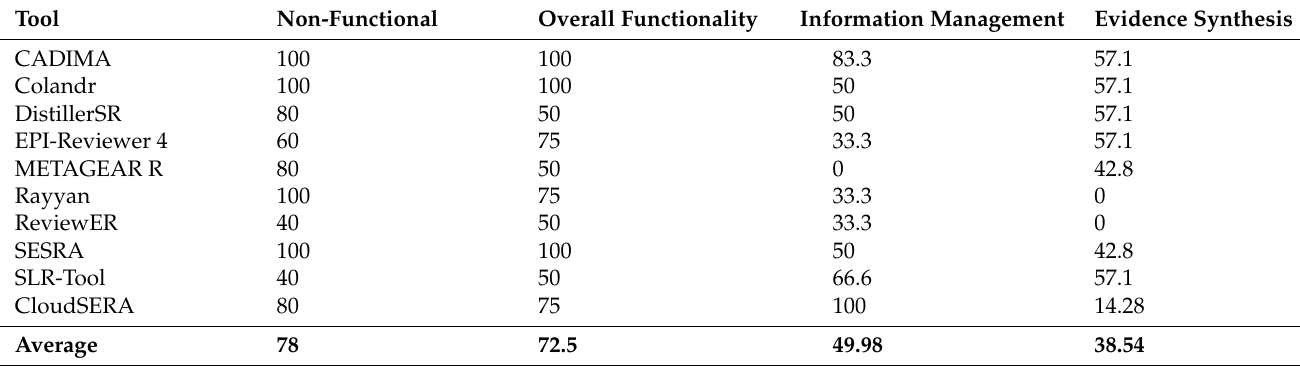
Table 3. Percentage results of the comparison of available features in SR process support tools.